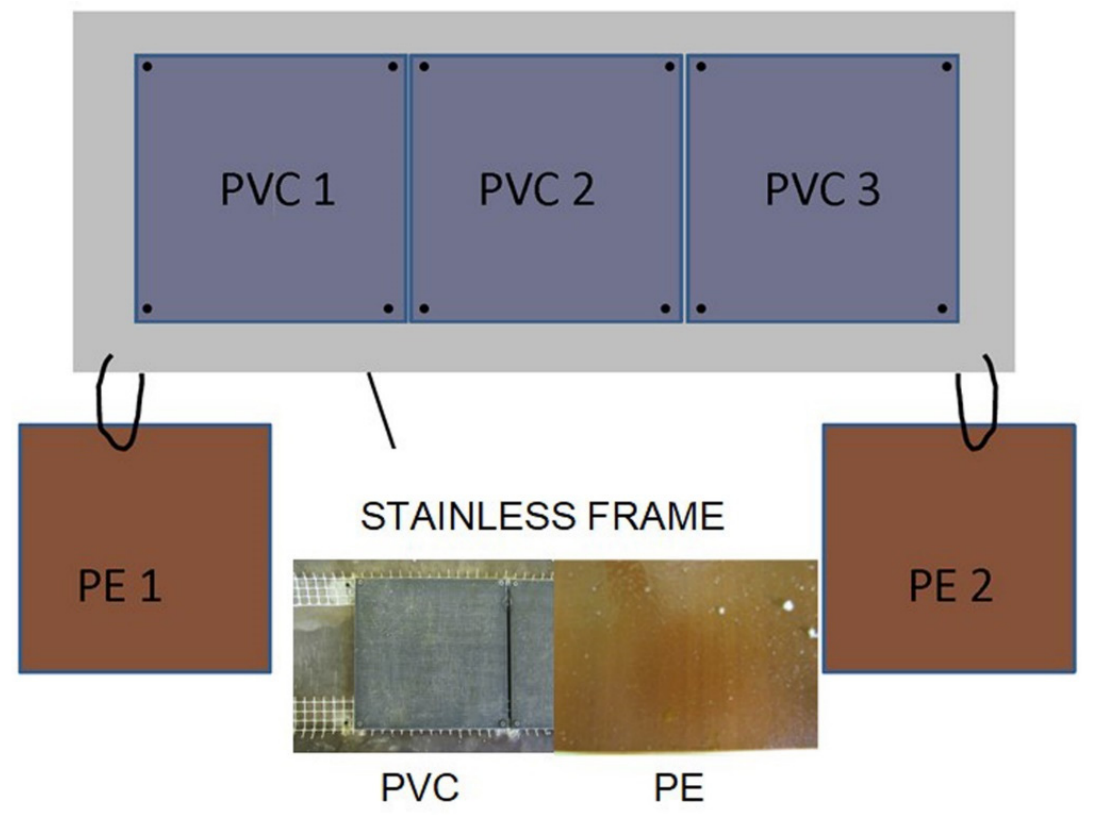
Figure 3. Scheme of the structure of the artificial settlement panels in the two study areas.